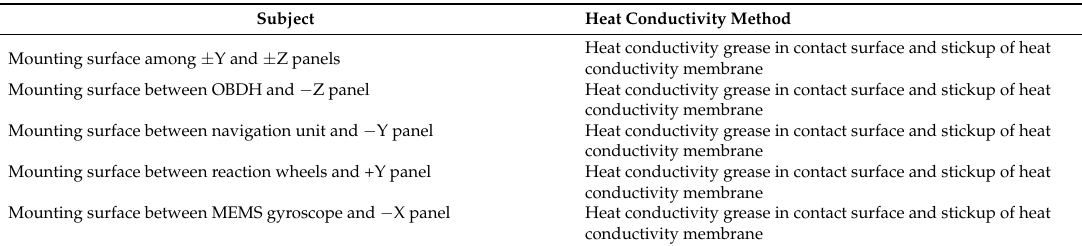
Table 10. Description of regions and method of thermal conductivity applied in Luojia